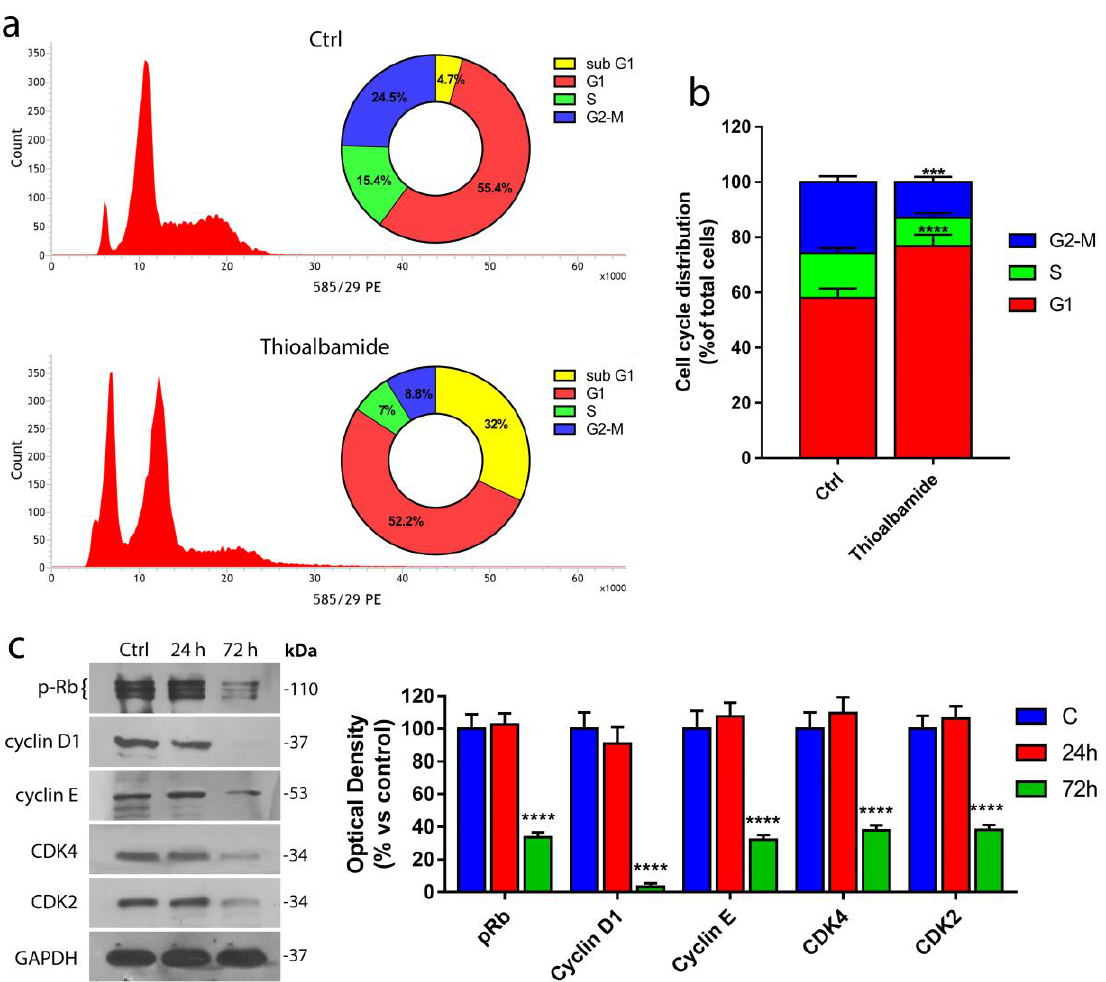
Figure 3. Thioalbamide inhibits cell cycle progression. ( a ) Cytofluorimetric analysis of MCF7 cells treated for 72 h with DMSO (control) or 50 nM thioalbamide and stained with PI; graphs represent the percentage of total events in the samples (highlighting the sub-G1 peak). ( b ) Cell cycle distribution of MCF7 cells (excluding sub-G1 events). ( c ) Immunoblot analysis of the main regulators of G1/S phase transition and quantification of their expression levels by densitometry. Note that thioalbamide treatment induces cell cycle arrest at the G1/S checkpoint. Values represent mean ± SD of three independent experiments. **** P value < 0.0001.